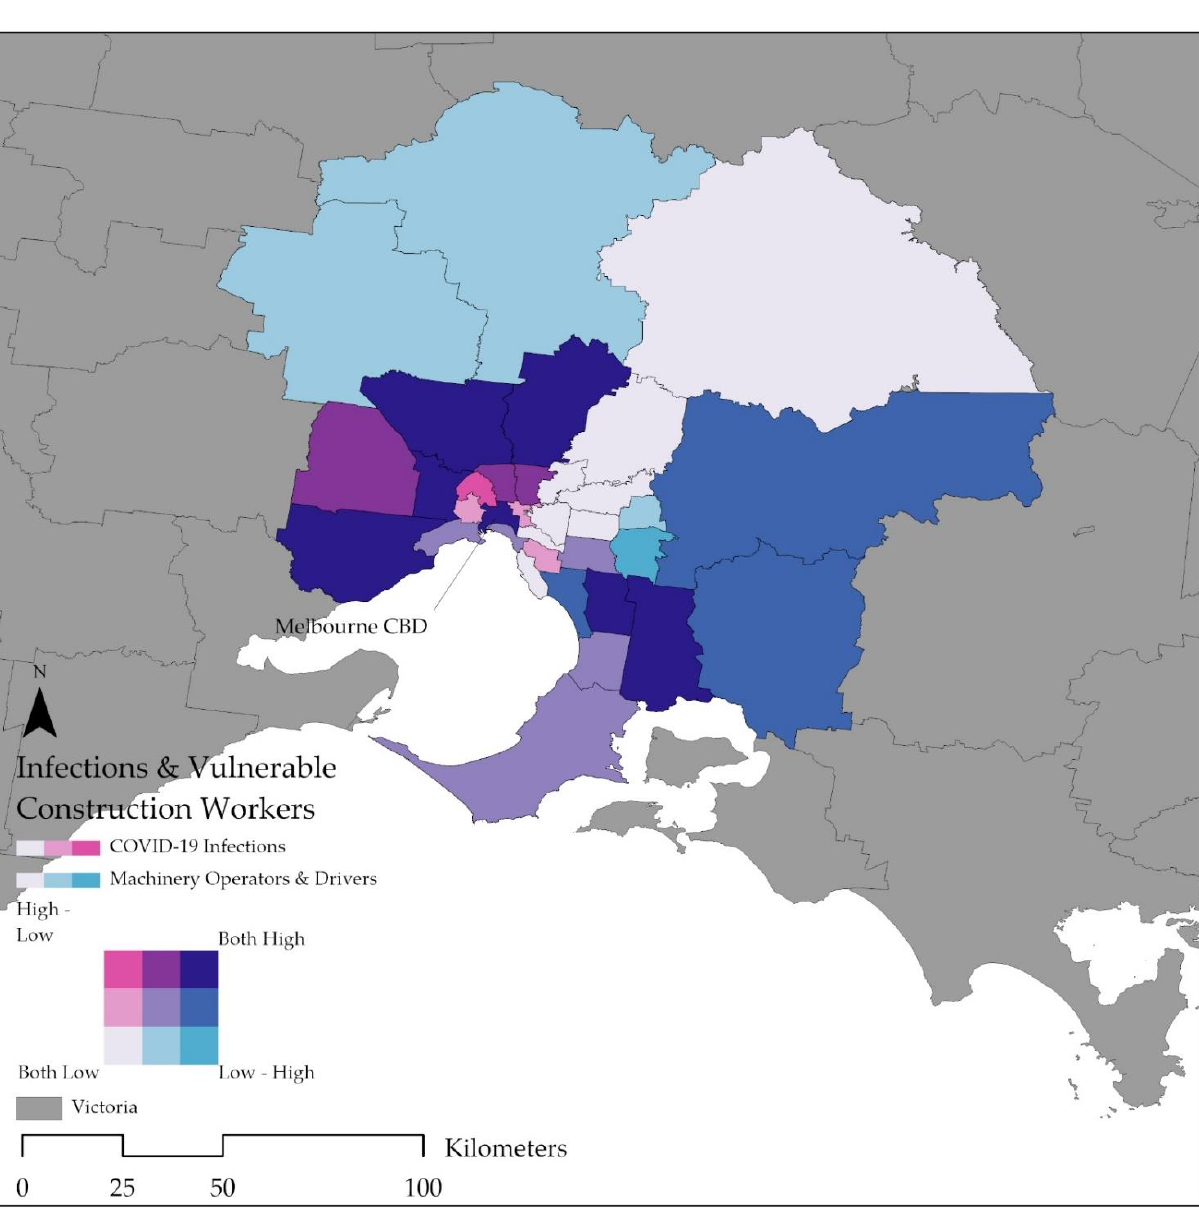
Figure 9. Bivariate choropleth map showing Melbourne LGAs with a high number of COVID-19 cases and a high number of Machinery Operators and Drivers.